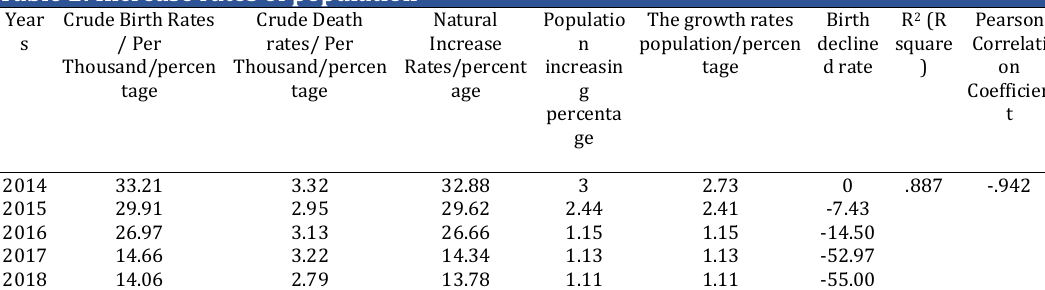
Table 2: Increase rates of population Year Crude Birth Rates s / Per Thousand/percen tage